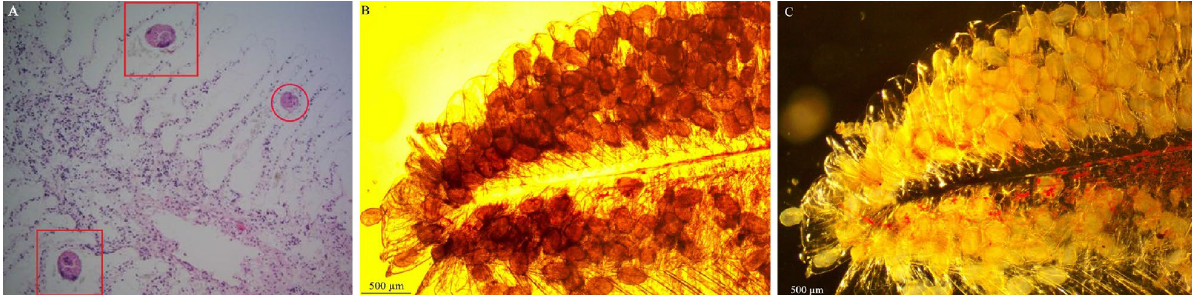
Figure 3. Microscopy of gill arch from Macrobrachium australiense. (A) Histopathology of the gill arch, noting the Temnocephalan egg (circle), and the appearance of damage to gill tissue surrounding eggs (squares); (B) microscopy of gill arch heavily infested with Temnocephalan eggs; (C) phase contrast microscopy of gill arch heavily infested with Temnocephalan Temnosewellia queenslandensis and Temnosewellia neqae , both of which have not been reported below the 28 th